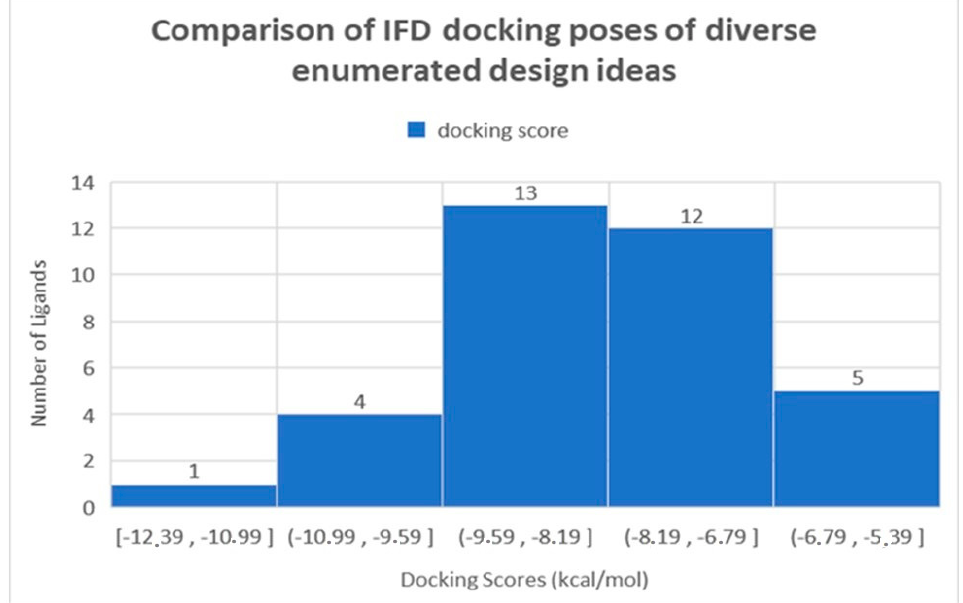
Figure 4. Histogram detailing the distribution of docking score (kcal/mol) for a diverse set of enumerated compounds measured using IFD, that were selected and prioritized for